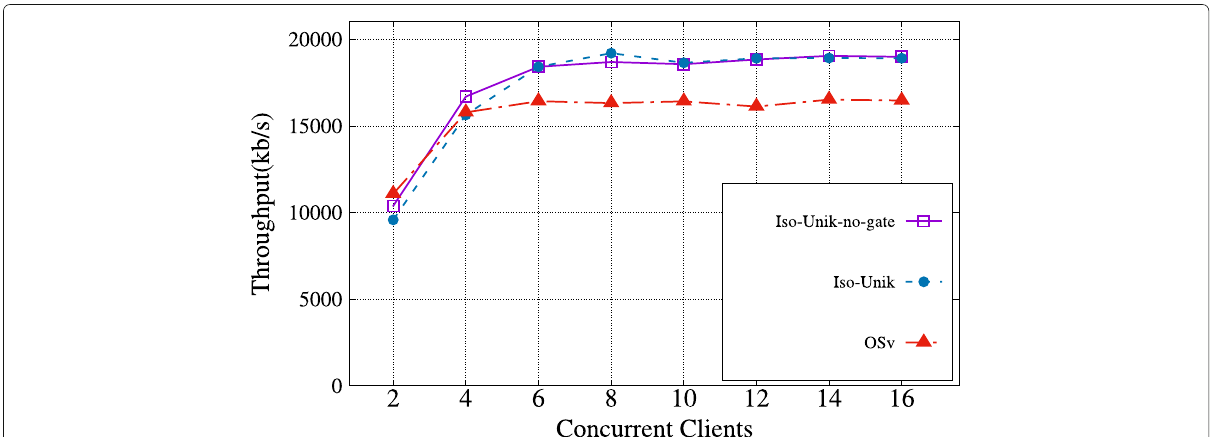
Fig. 6 The throughput (in kbytes/second) of Nginx server. Two processes in Iso-UniK, and one process in origin OSv